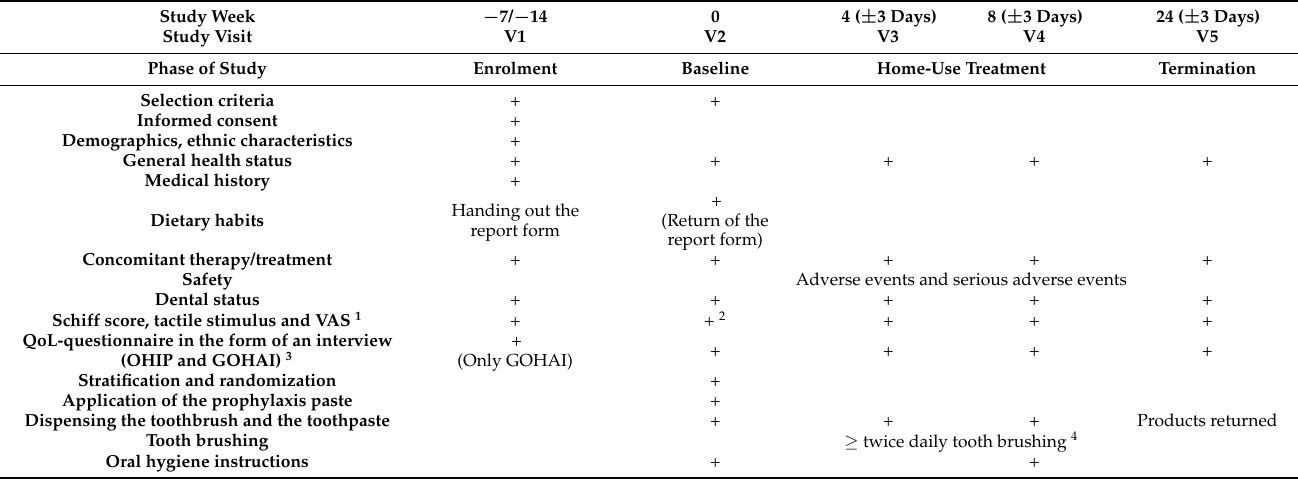
Table 1. Timeline (study flow